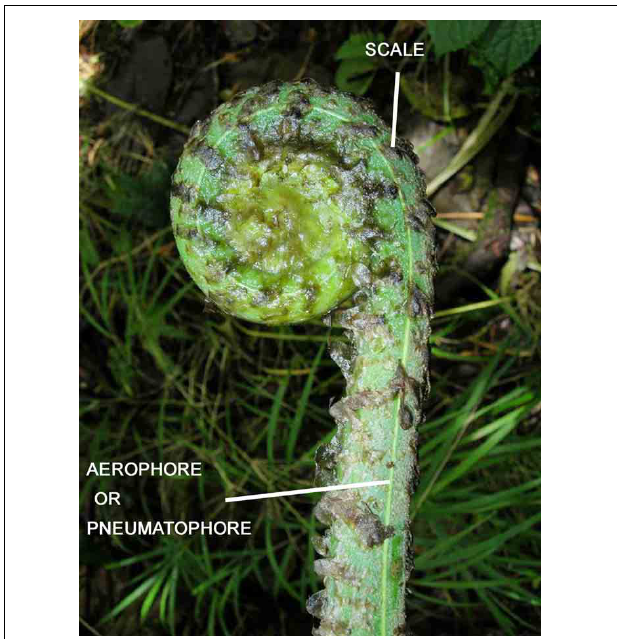
FIGURE 6 | Fiddlehead and aerophore (or pneumatophore) of Pteris livida (Pteridaceae).